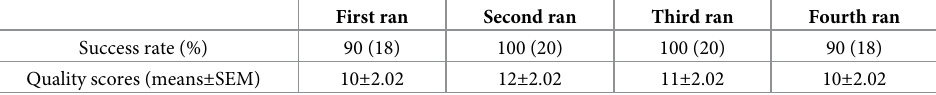
Table 3. Repeatability tests on slice quality scores and qualified section success rates with BTA in 4 separate